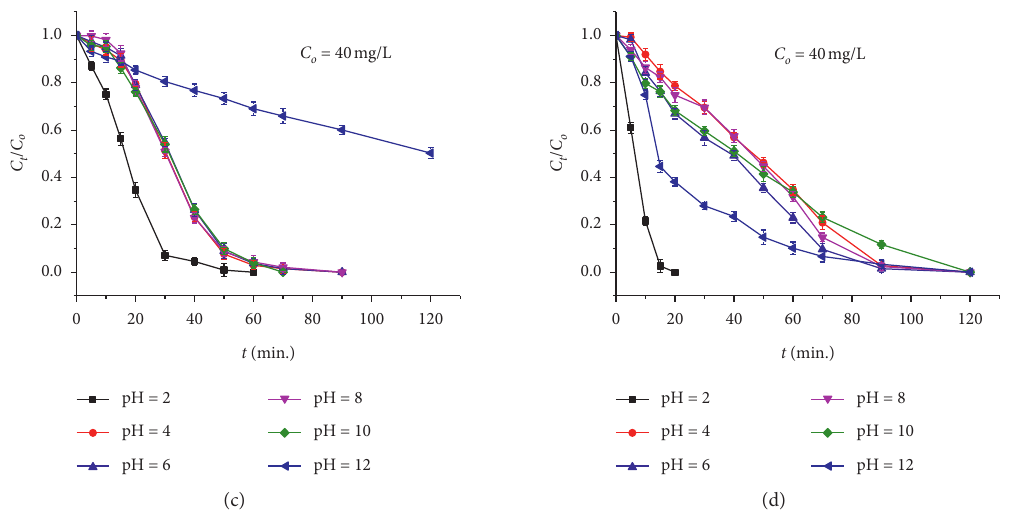
Figure 12: Decomposition of organic compounds by H 2 O 2 on MIL-53(Fe) catalyst at different initial solution pHs: (a) PhN; (b) HPLC chromatograms of the PhN oxidation reaction solution after 40 minutes of reaction; (c) RhB; (d) MtB.